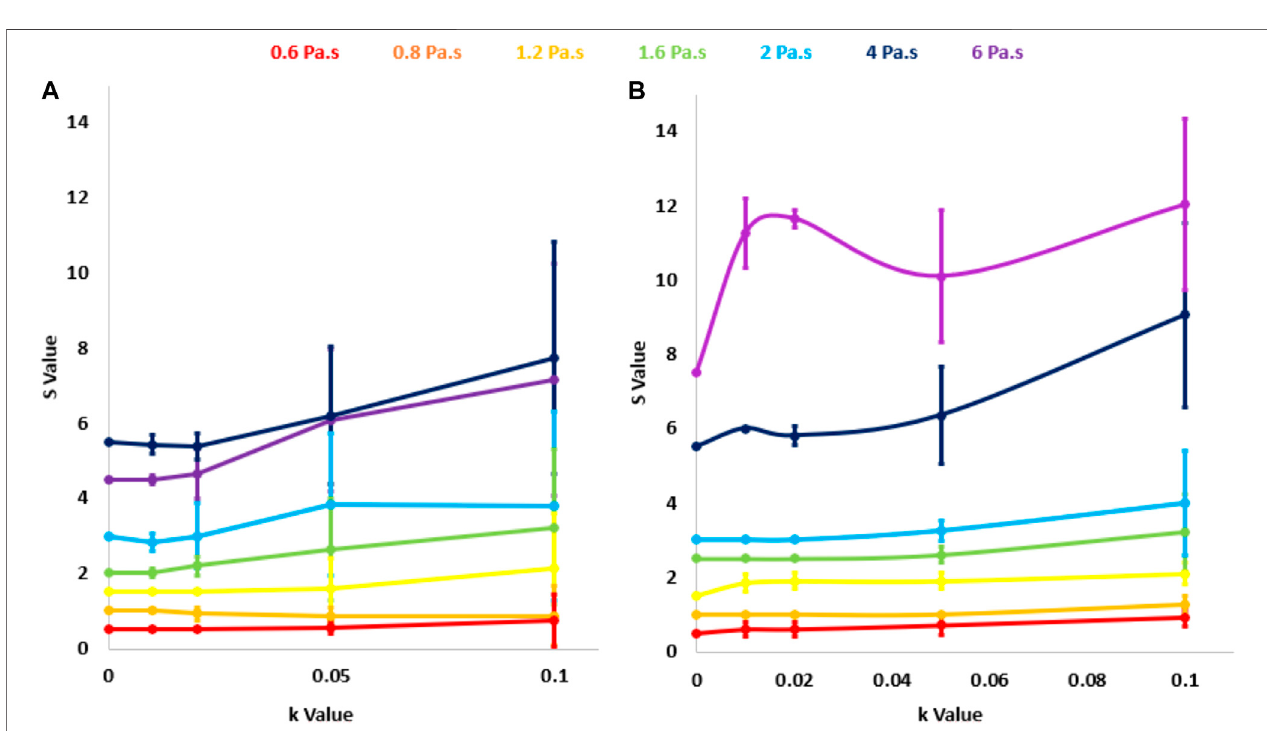
FIGURE 7 | S parameter calculated with the automated low-pass fi lter (A) and the singular value decomposition fi lter (B) as a function of the noise level k . Each curve corresponds to a different degree of viscosity η .